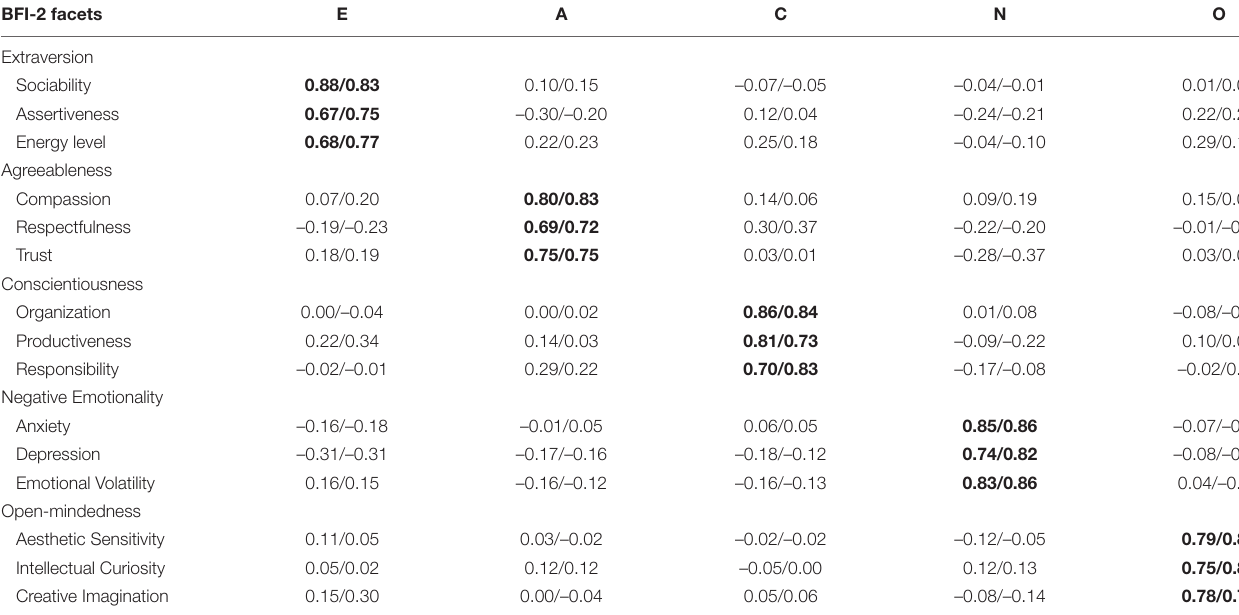
TABLE 2 | Loadings from a principal component analysis of scores from the 15 BFI-2 facets (Study 1 and 2). BFI-2 facets